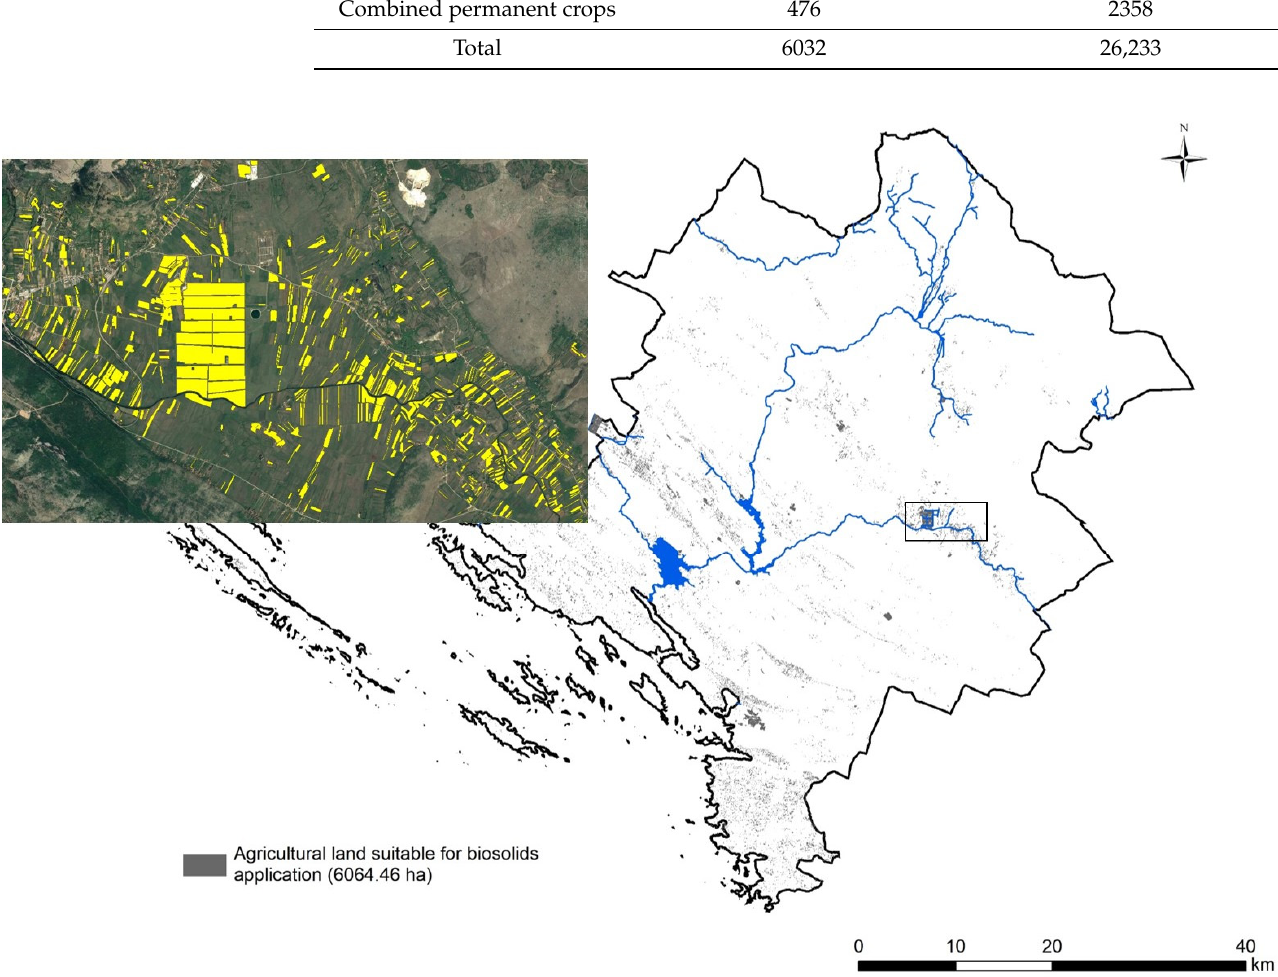
Figure 4. Agricultural land parcels suitable for biosolids application. The enlarged section shows the differences in size and spatial distribution of these parcels in Petrovo polje .